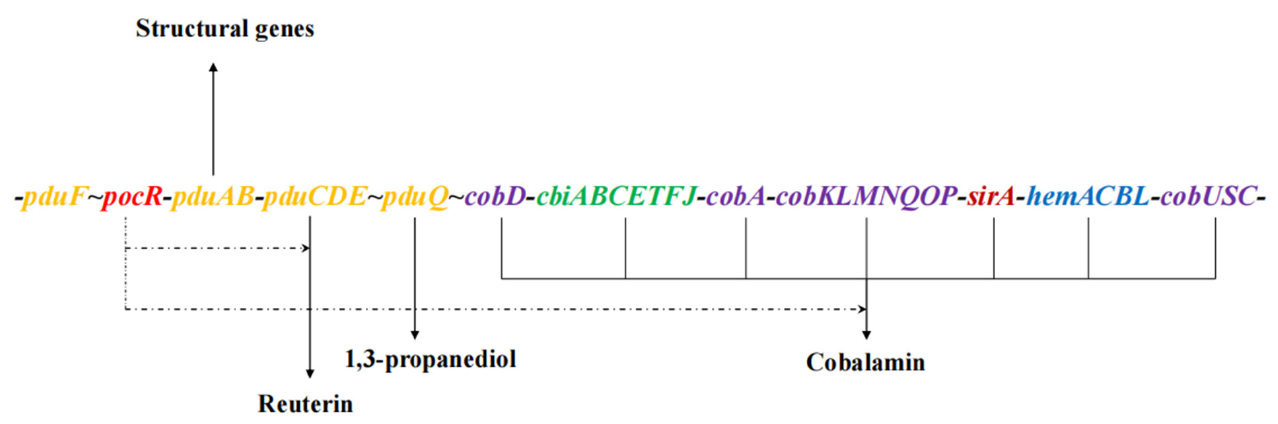
Figure 2. Genetic arrangement of reuterin and cobalamin in L. reuteri [27,28]. Yellow, pdu including gupCDE genes; Purple, cob genes; Green, cbi genes; Blue, hem genes; Red, pocR . The pocR gene regulates the synthesis of reuterin and cobalamin.